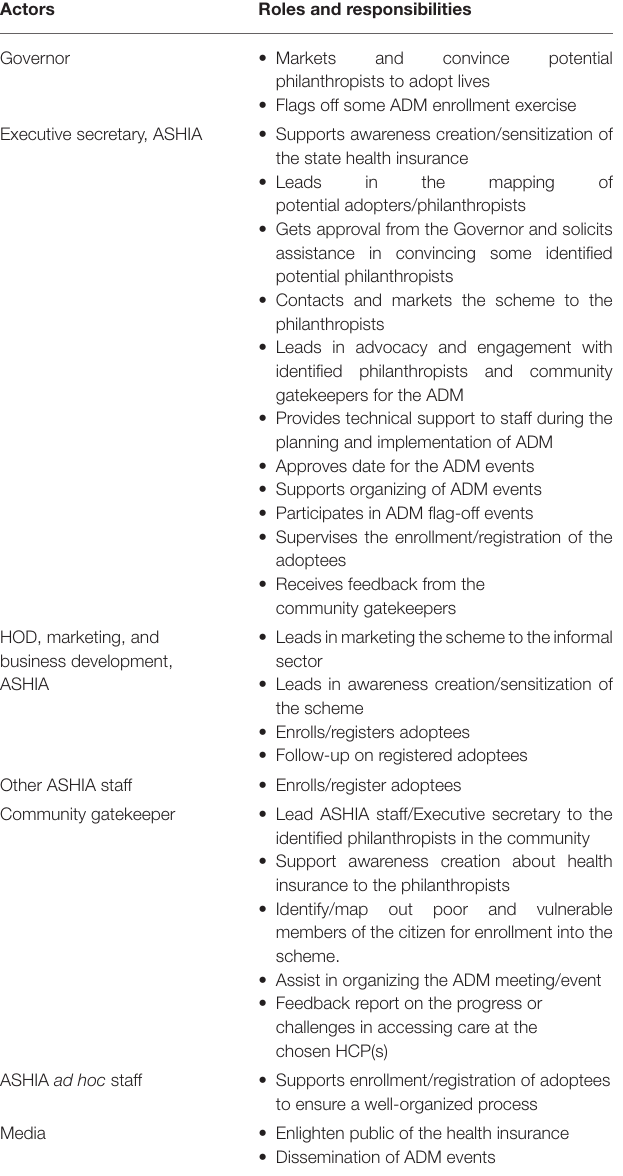
TABLE 2 | Key actors involved in the ADM of health insurance and their roles.